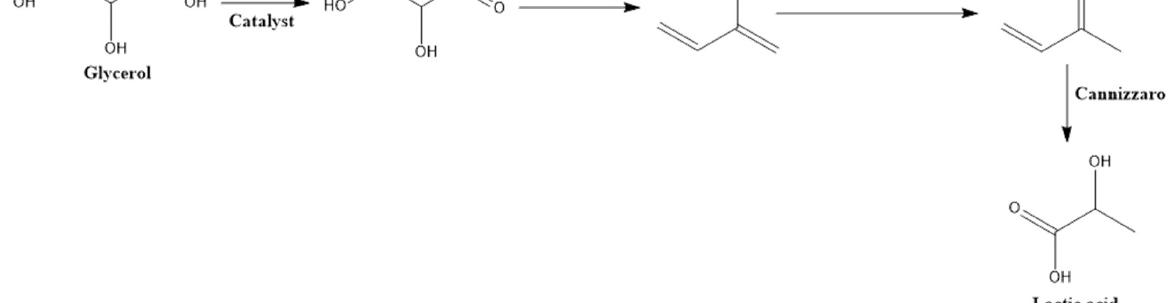
Figure 10. The reaction pathways for converting glycerol to lactic acid by oxidation [126]. Copyright 2021, Elsevier.